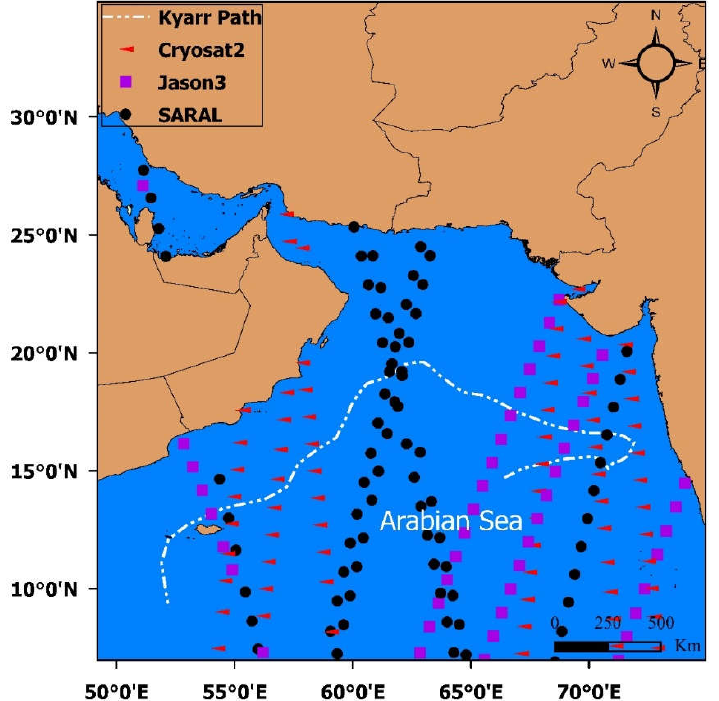
Figure 8. Location of satellite altimeter measurements of wave height during tropical Cyclone Kyarr.